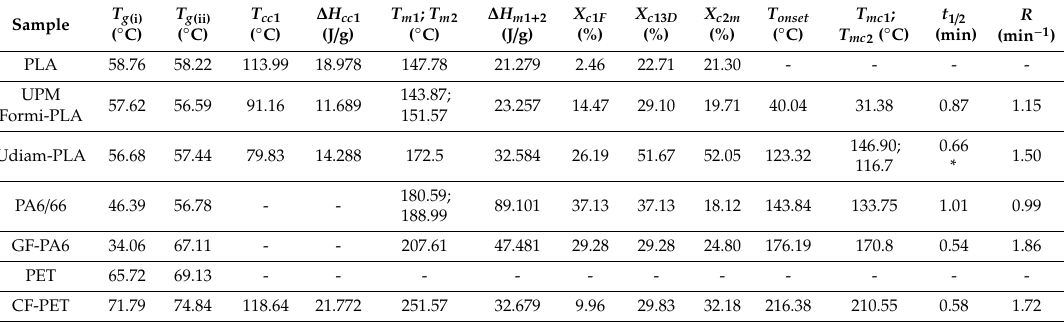
Table 3. Non-isothermal crystallization parameters of di ff erent printing filaments.